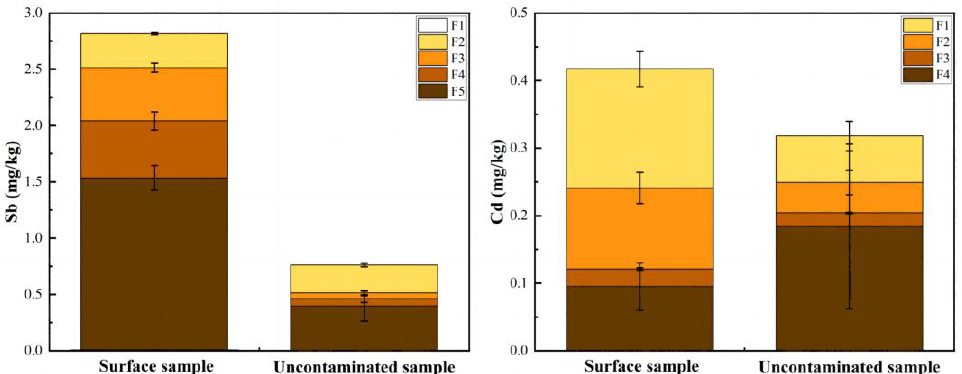
Figure 4. Fractionation of Sb and Cd in 16 samples from TP7 of Taipu River sediments by Wenzel and BCR methods, respectively. The F1, F2, F3, F4 and F5 represent non-specifically sorbed, specifically sorbed, amorphous and poorly-crystalline hydrous oxides of Fe and Al, well-crystalline hydrous oxides of Fe and Al and residual phases in Wenzel, respectively. The F1, F2, F3 and F4 represent acid extractable, reducible, oxidizable and residual fractions in BCR, respectively. Error bars represent the standard deviation of 5 surface layer samples and 11 deep layer samples.